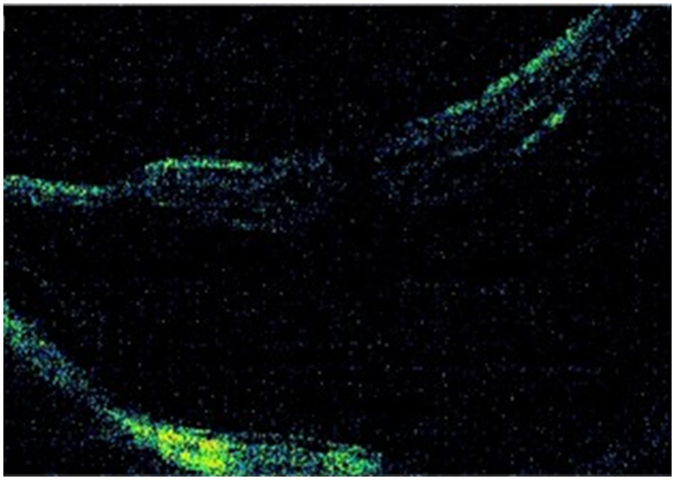
The patient was 59 years old, female, with a logMAR BCVA of 1.30, and the axial length was 29.99 mm.The preoperative optical coherence tomography (OCT) image of the left eye revealed a significant macular hole retinal detachment (MHRD).